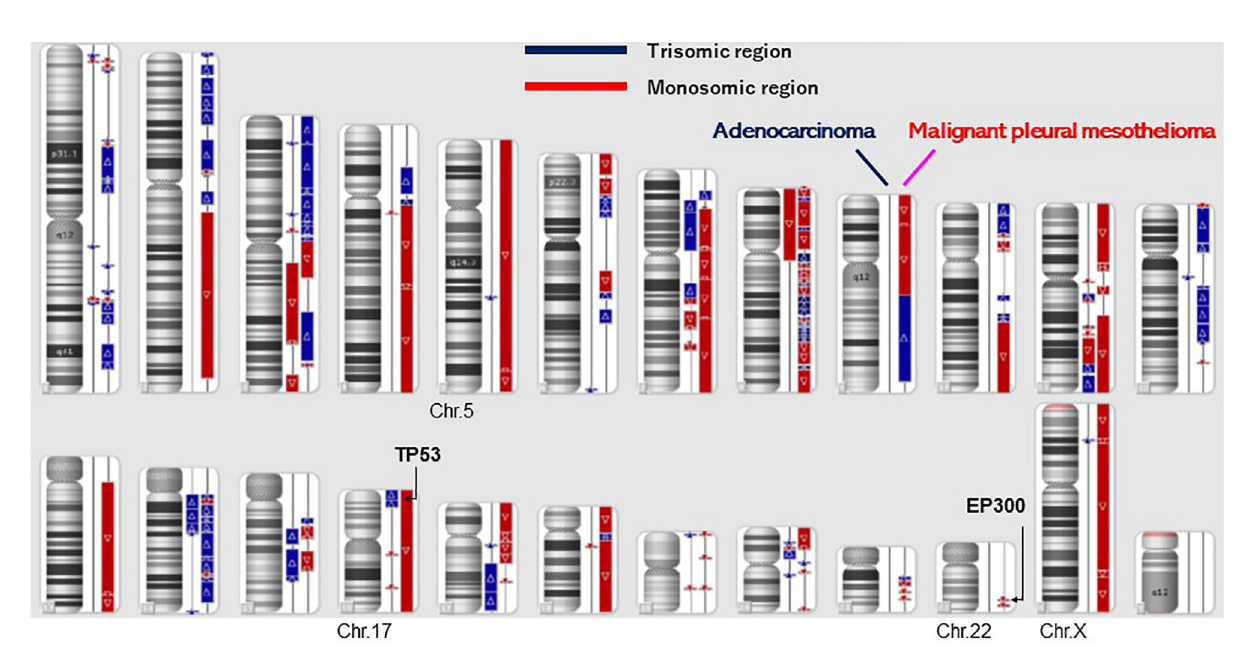
FIGURE 3 | Structural chromosomal aberration analysis by DNA microarray (OncoScan CNV). All chromosomes showed abnormality in malignant pleural mesothelioma, whereas the chromosomal aberration of lung adenocarcinoma was relatively local. A commonality was not found in the patterns of the chromosomal aberration between the adenocarcinoma and the malignant pleural